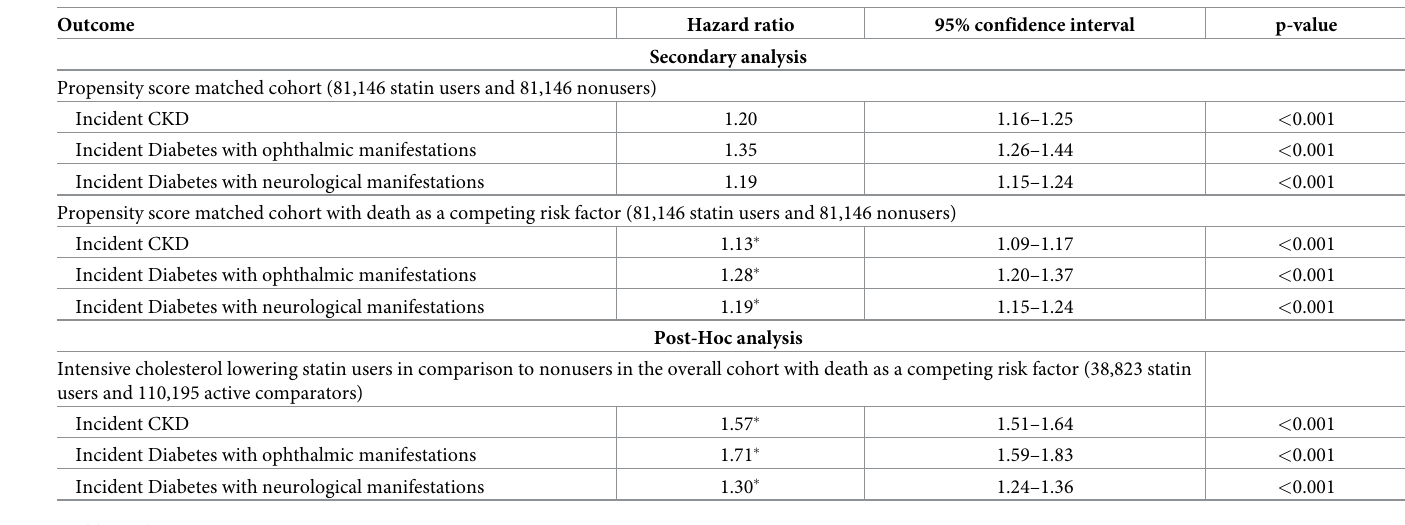
Table 4. Hazard/Subhazard ratio of outcomes in statin users in comparison to